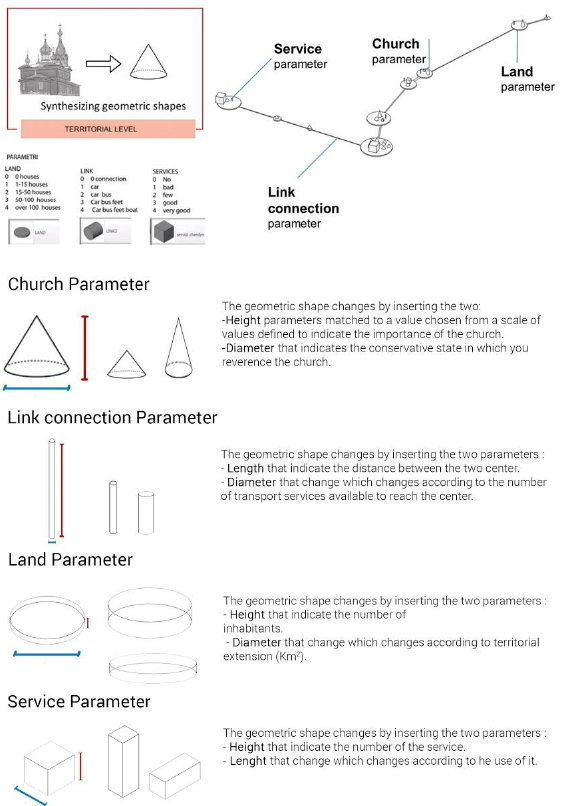
Figure 7. First considerations made on the construction of a simplified informative model of the territory. The simplified three-dimensional geometric forms define and describe the characteristics of the territory through the insertion of specific parameters. Each simplified model of church is expected to connect a more detailed model that describes the different technological elements in